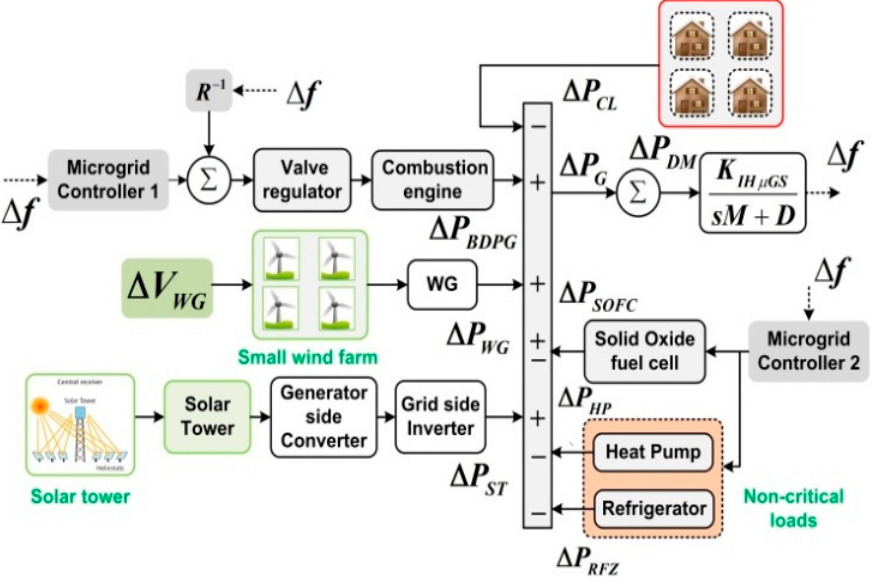
Figure 1. Schematic representation of IH µ GS . Table 1. Utilized symbols and